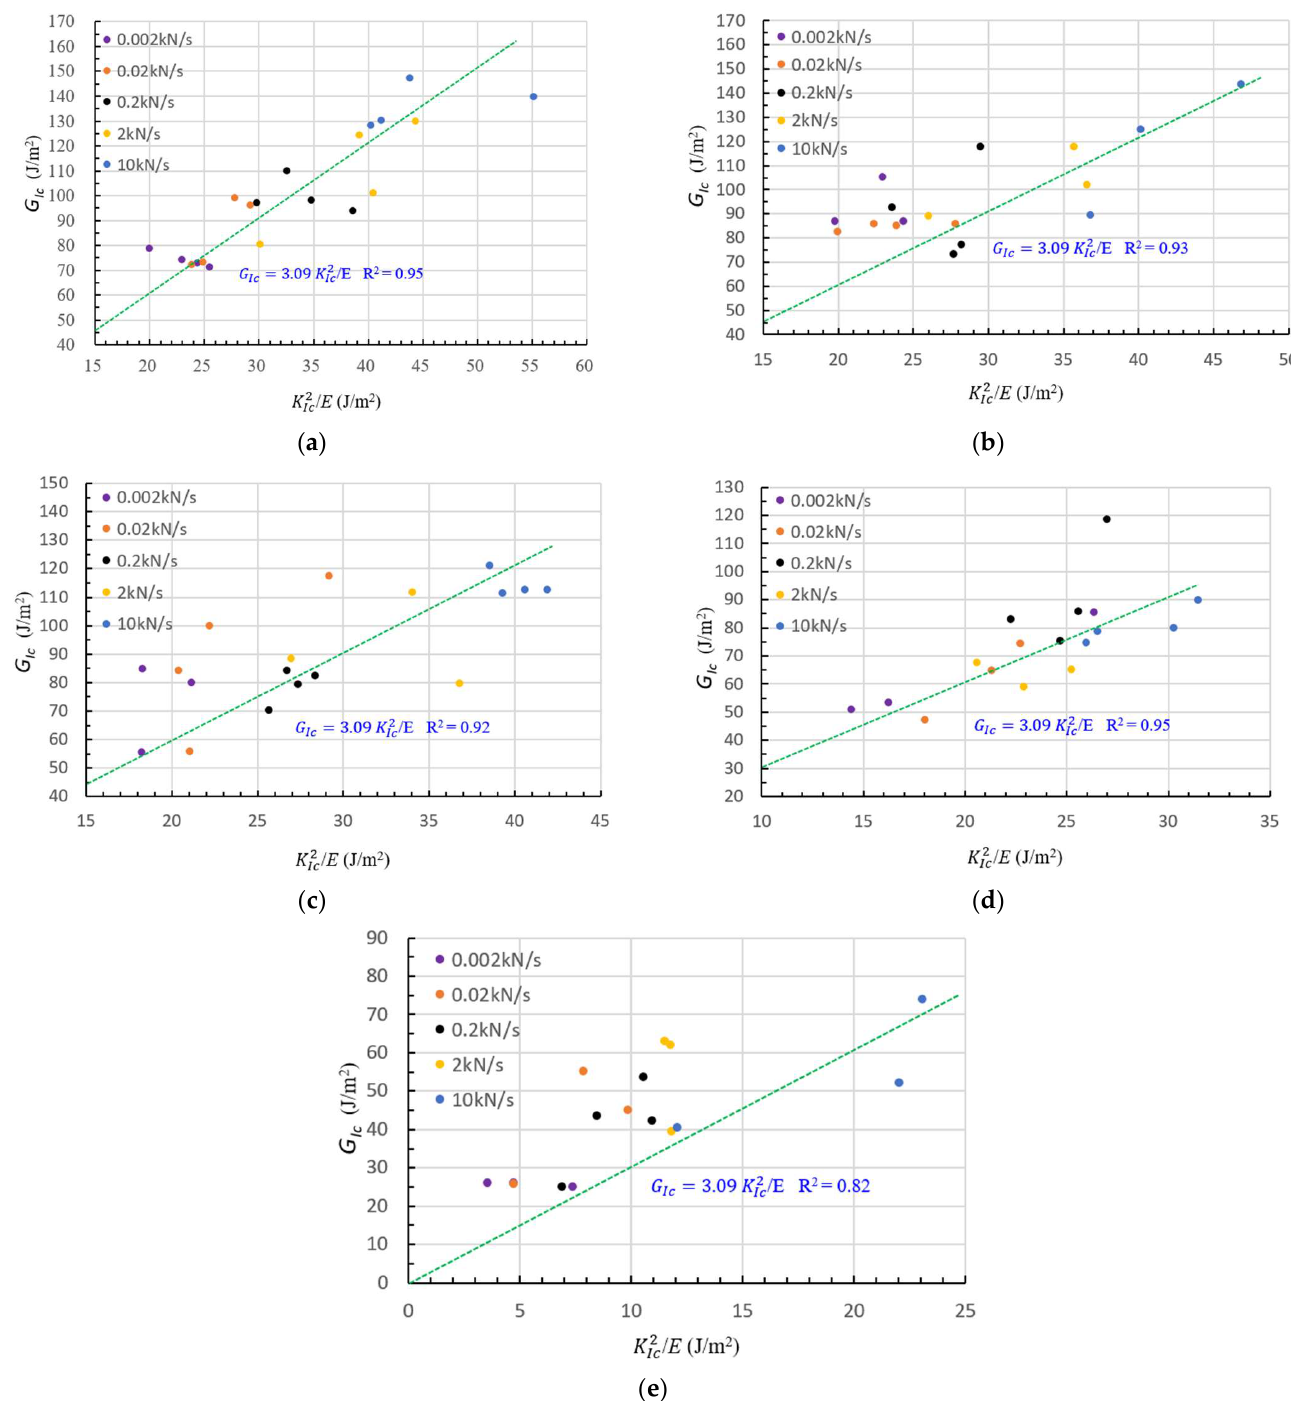
Figure 5. ( a ) Regression equation and data for Φ = 150 mm. ( b ) Regression equation and data for Φ = 100 mm. ( c ) Regression equation and data for Φ = 75 mm. ( d ) Regression equation and data for Φ = 50 mm. ( e ) Regression equation and data for Φ = 30 mm.